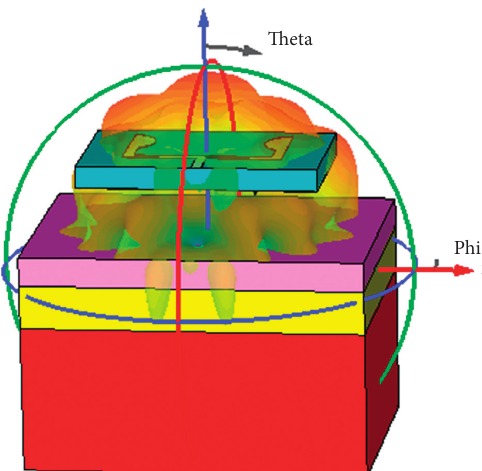
Figure 24: Array 2 on-body 3D radiation pattern at